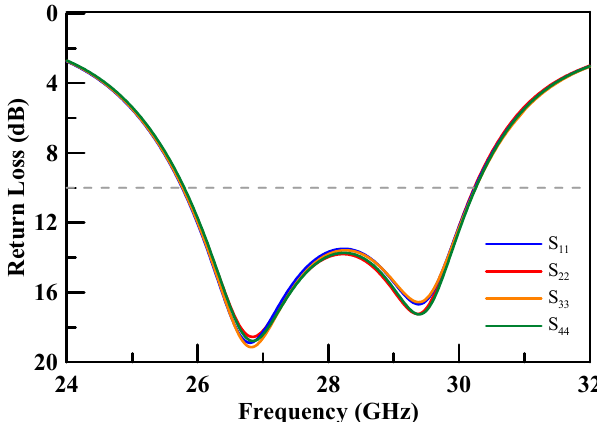
Figure 7. Four (4) ports return loss of the simulation.